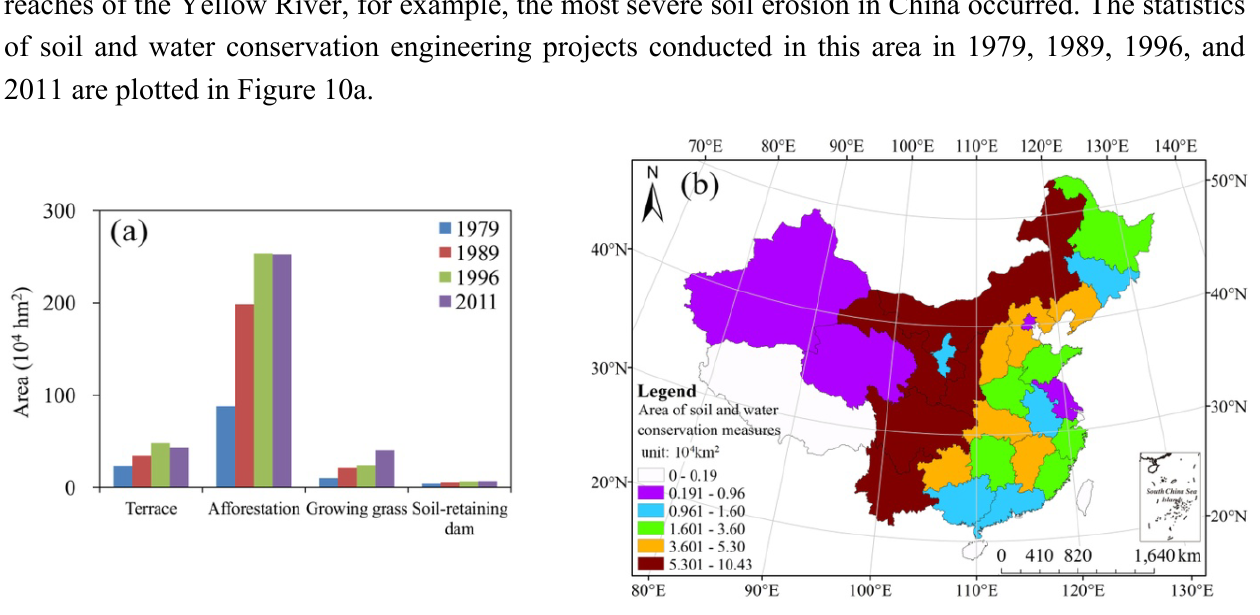
Figure 10. Statistics of soil and water conservation engineering areas in ( a ) the middle stream of the Yellow River basin (YRB) and ( b ) the national